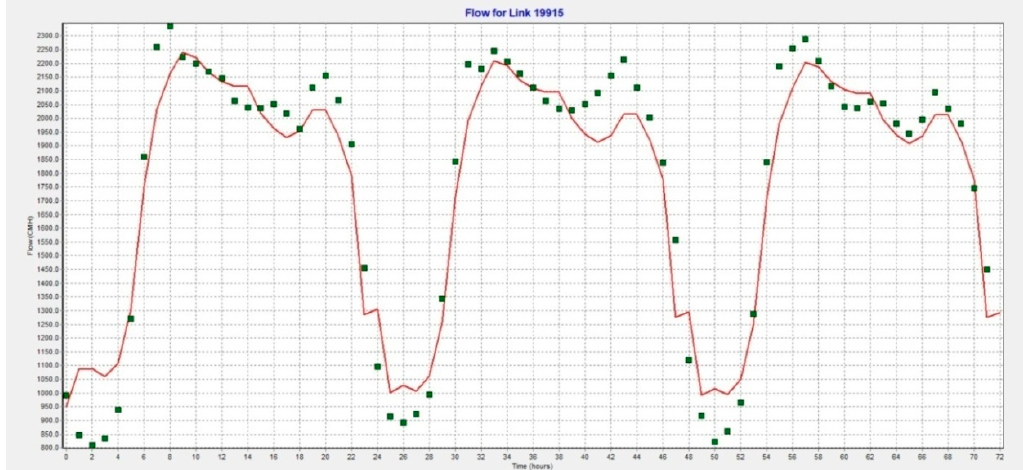
Figure 10. Results of Scenario II for Tanks E, west